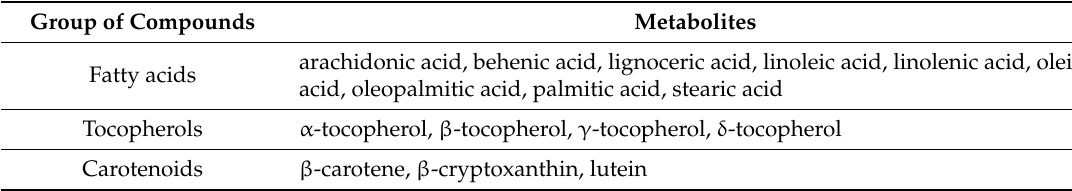
Table 5. Composition of oil from C. limon seeds.